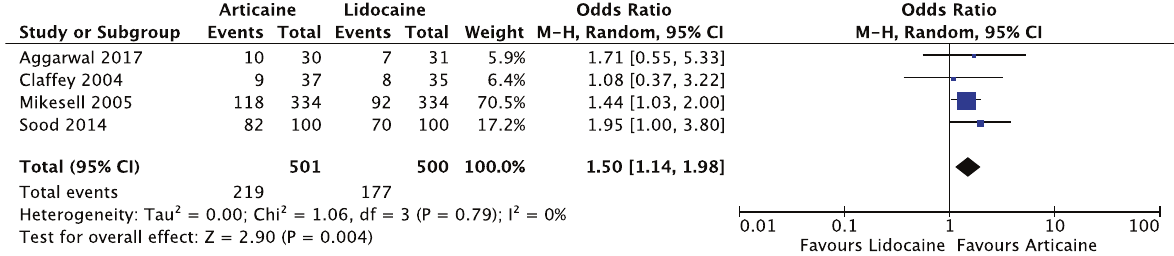
Fig. 6 Forest plot — mandibular inferior alveolar nerve blocks. Articaine had 1.5 times the likelihood of anaesthetic success of lidocaine.